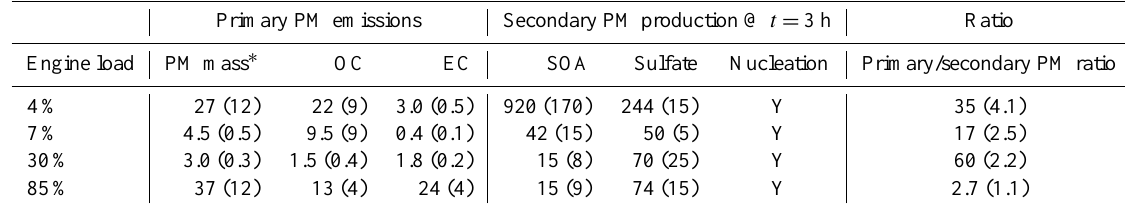
Table 1. Summary of primary PM emissions and secondary aerosol production. Uncertainty estimates are presented in parenthesis.